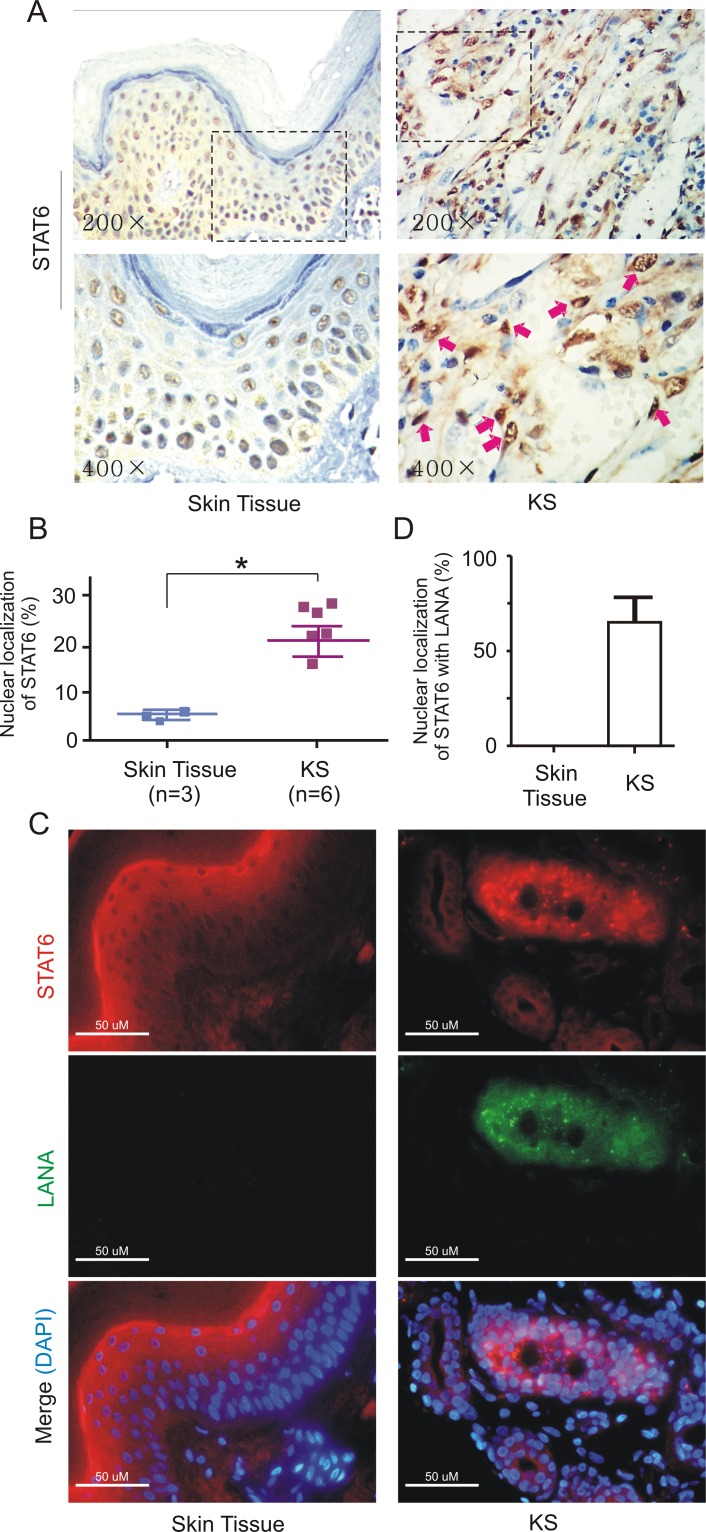
Nuclear localization of STAT6 occurs in KS patient tissues.(A) Representative images of immunohistochemistry staining against STAT6 in KS patient tissue and normal skin tissue. The larger magnification (x400) image and relative percentage of staining cells with STAT6 nuclear localization (Arrow) is shown in the lower panels. (B) The relative percentage of STAT6 nuclear localization from panel A was individually quantified by nuclear and cytoplasmic staining of 100 cells. Asterisks indicate P<0.05. (C) Immunofluorescent analysis of endogenous STAT6, LANA and merged in KS patient tissue and normal skin tissue. Nuclei were stained with DAPI. Scale bars represent 50μM. (D) The relative percentage of STAT6 nuclear localization in the presence of LANA from panel C was individually quantified by nuclear and cytoplasmic staining of 100 cells.